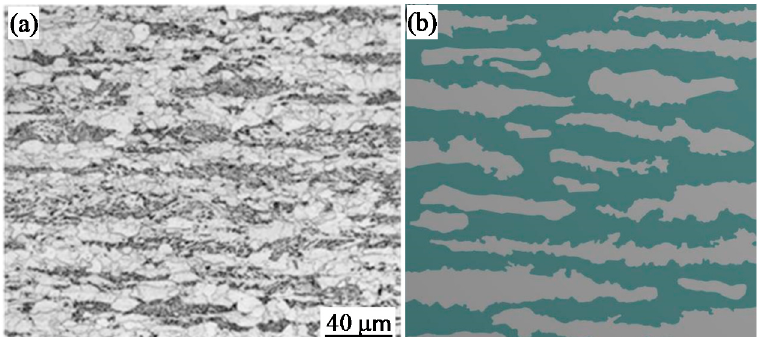
Figure 1. ( a ) Optical microstructure of dual-phase X80 pipeline steel and ( b ) abstract RVE model based on mesostructure.